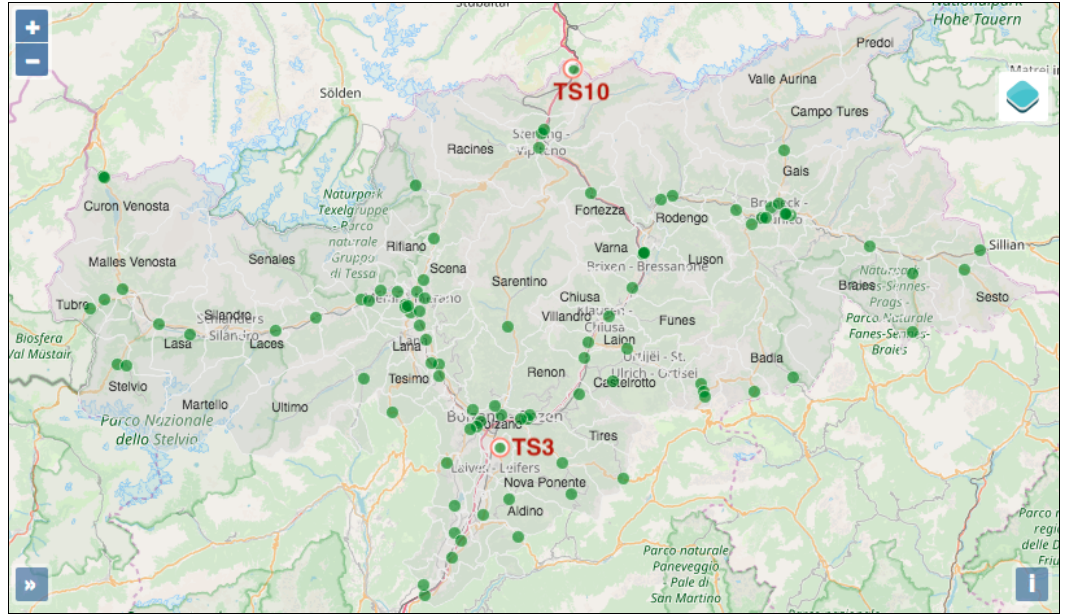
Figure 7. The locations of traffic stations with TS3 and TS10 being highlighted.